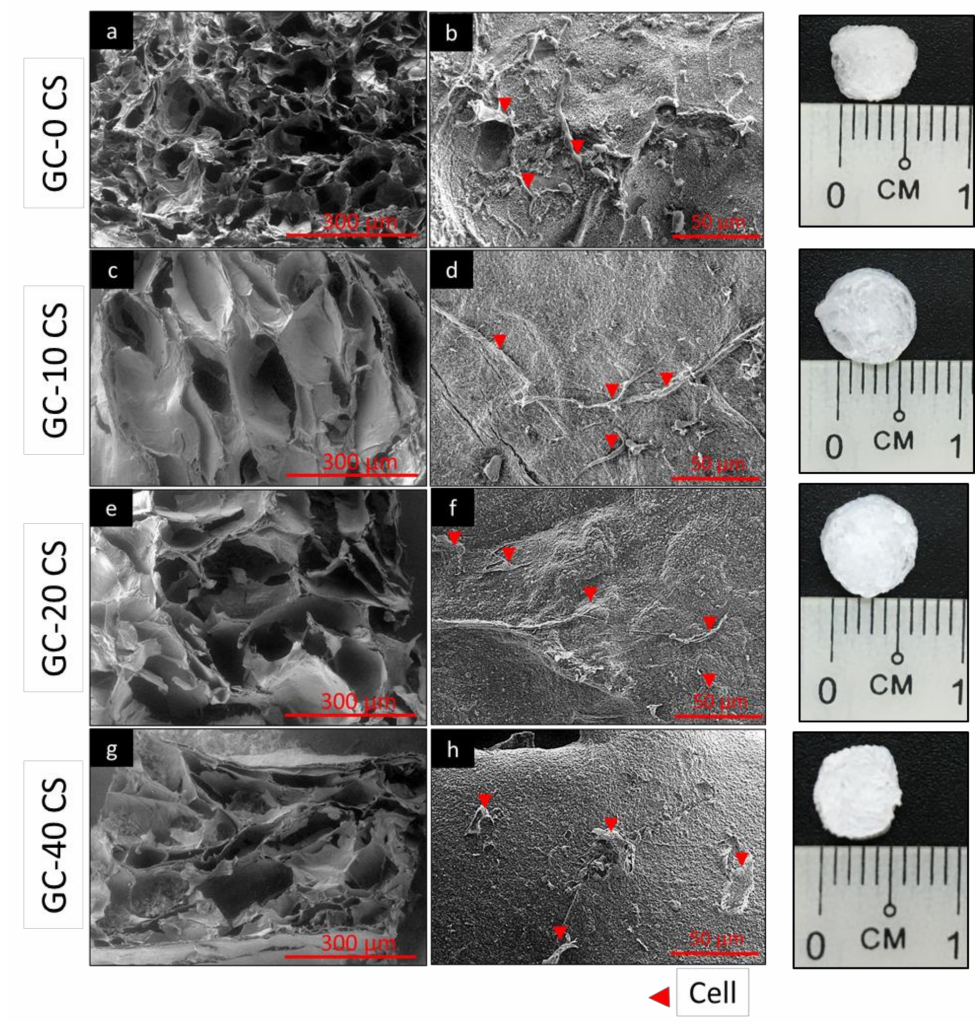
Figure 1. Scanning electron microscopy: ( a , b ) GC-0 CS, ( c , d ) GC-10 CS, ( e , f ) GC-20 CS, and ( g , h ) GC-40 CS